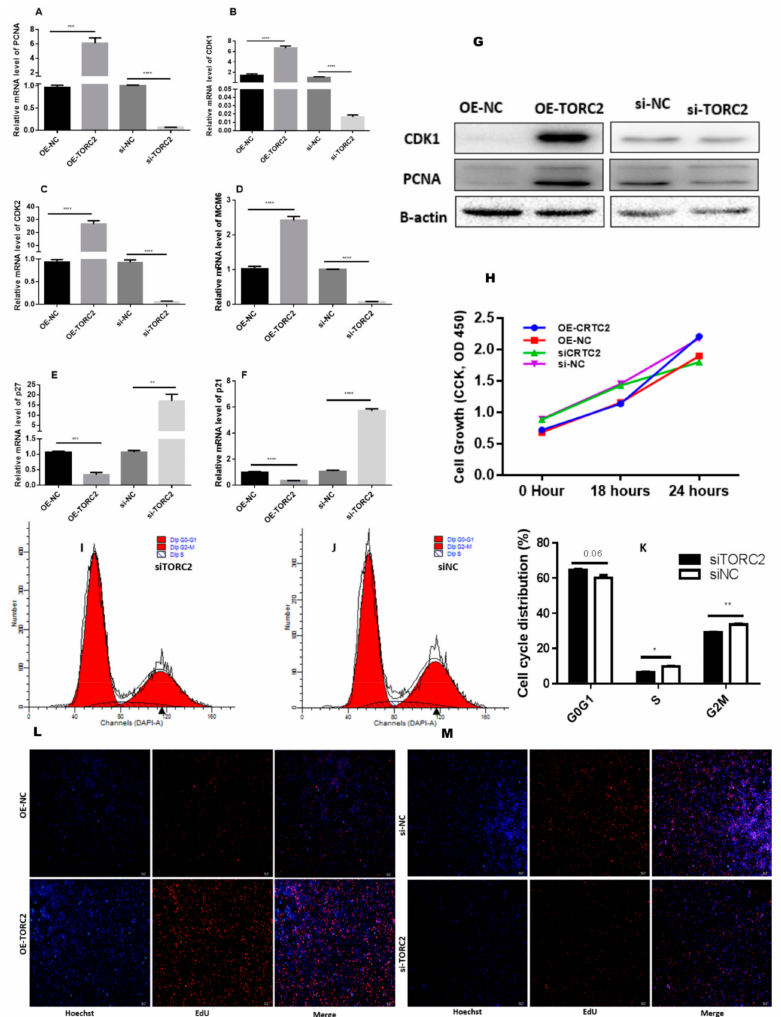
Figure 2. TORC2 promotes adipocyte proliferation. OE-NC , OE-TORC2 , siNC, or siTORC2 were transiently transfected into bovine preadipocytes at 50% to 60% confluence, and cells were harvested at 24 h after transfection. ( A – F ) Real time qPCR was used for the detection of cell cycle genes, PCNA, CDK1 , CDK2 , MCM6 , p21 and p27 24 h after transfection. ( G ) Western blot analysis of the cell cycle genes. ( H ) Cell count was measured using a cell count kit 8 (CCK-8), and the results show absorbance values at a wavelength of 490 after incubation with 10% CCK-8 solution for 3 h. The plots of cell cycle analysis in di ff erent cell cycle phases were compared ( I – K ) Cell cycle analysis was performed through a flow cytometer 24 h after transfection. ( L , M ) EdU (5-ethynyl-2 (cid:48) -deoxyuridine) assay was performed 24 h after transfection. Cells during DNA replication were stained by EdU (red), and the cell nuclei were stained with Hoechst (blue). The values represent mean ± SEM ( n = 3). * p < 0.05 and *** p <